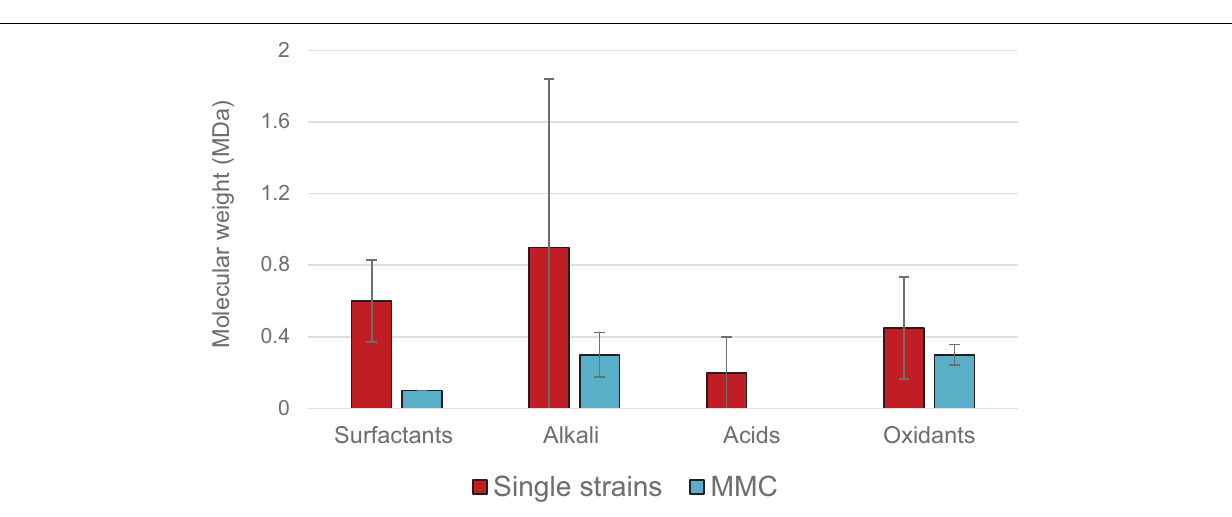
FIGURE 6 | Mean molecular weight (MDa) of PHA extracted with solvents (halogenated solvents, alcohols, ketones, and carbonates) from single strains or MMC.